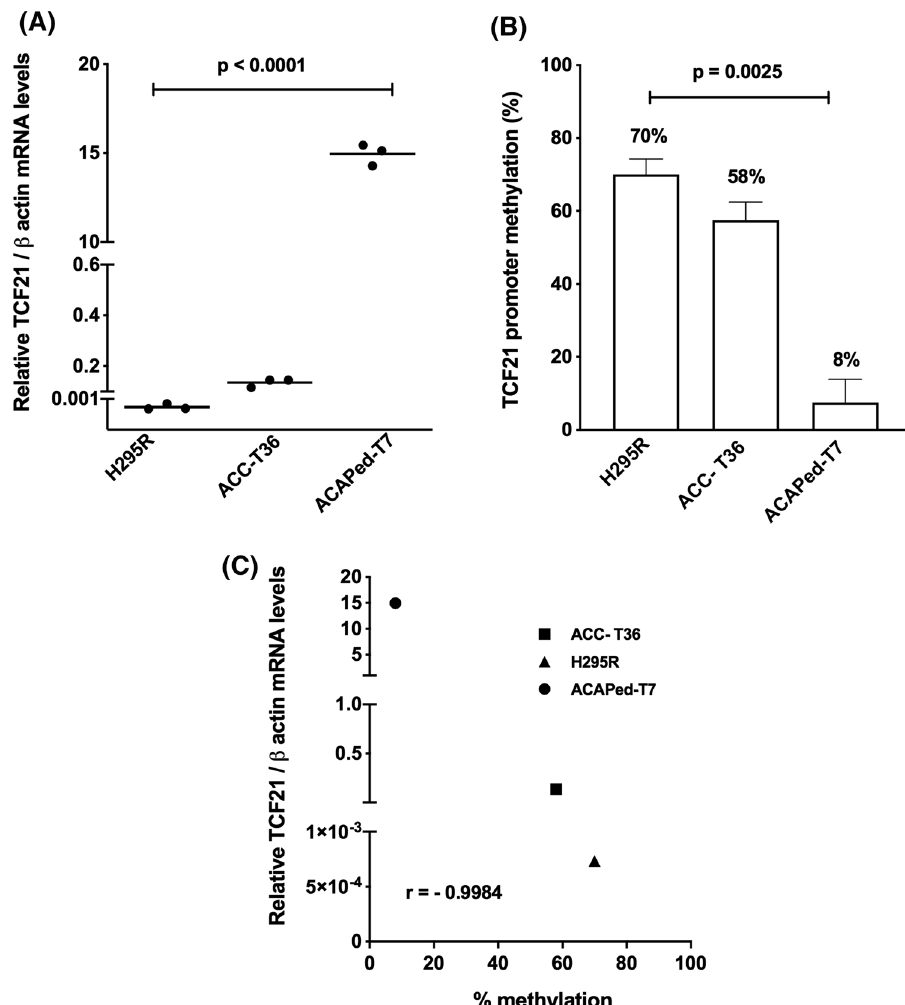
Fig. 1 TCF21 expression and promotor methylation. A Relative TCF21 expression in adrenocortical tumor cells; B Methylation levels of TCF21 promoter; C Negative Pearson’s correlation between TCF21 expression and level of promoter methylation ( r = − 0.9984). NA normal adrenal pool; ACC-T36 adreno- cortical carcinoma cell culture from patient; ACAPed-T7, pediatric adrenocortical adenoma cell culture from patient; H295R cell line. The experiments were performed in triplicate and repeated three times. The results were expressed as the mean ± SD. Statistical significance was assessed by One-way